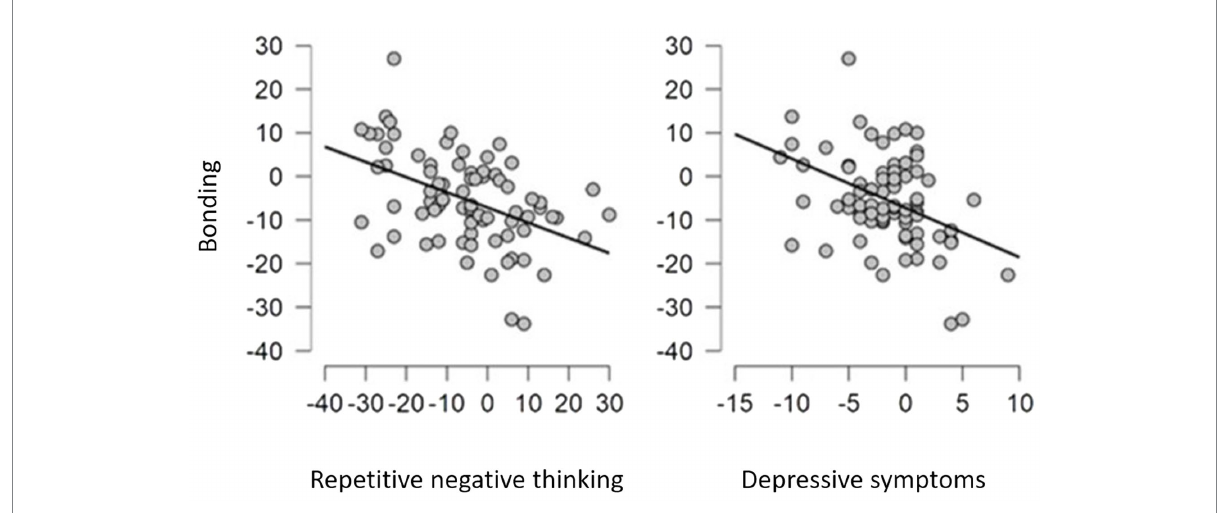
FIGURE 2 Plots of associations between difference in bonding within couples and the difference in repetitive negative thinking and depressive